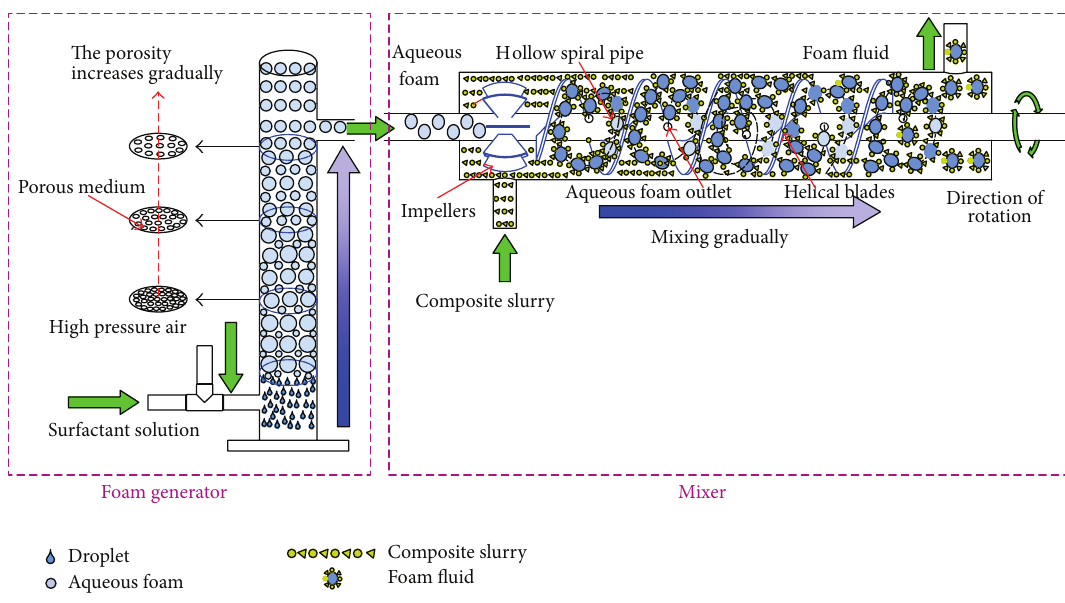
Figure 3: The schematic of foam generator and self-made